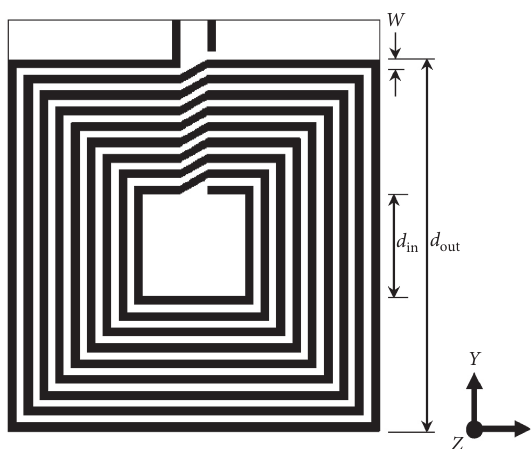
Figure 1: The configuration of square spiral HF-RFID tag